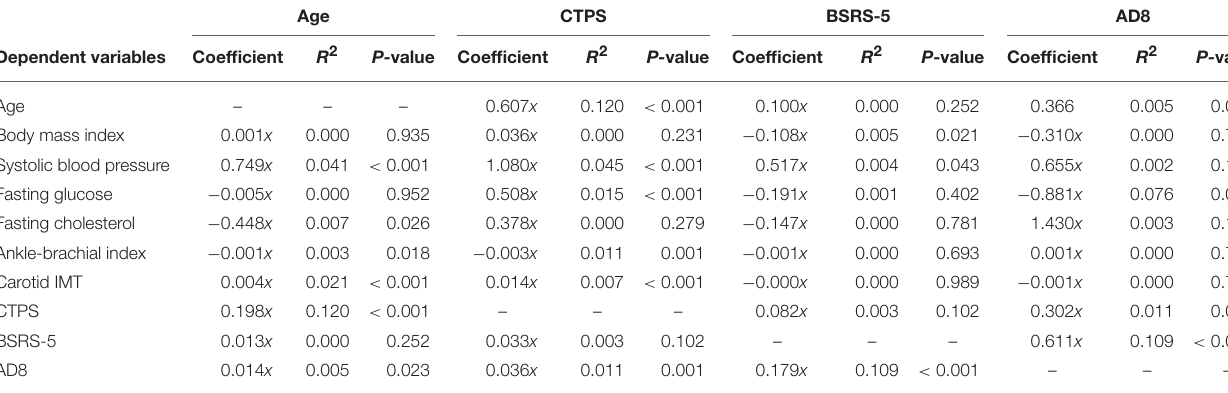
TABLE 4 | Simple linear regression analyses of age, TCPS, BSRS-5, and AD8 with measured variables in 985 volunteers.